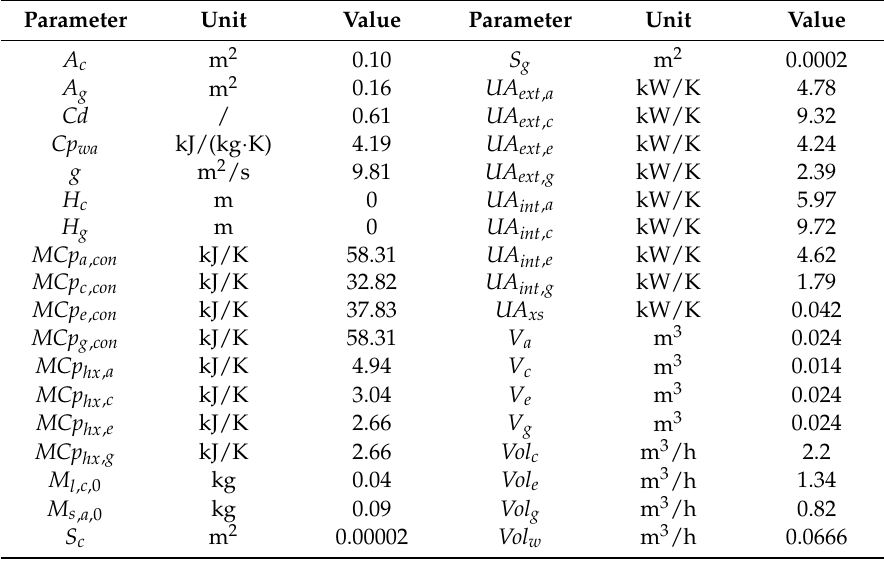
Table 1. Constant parameters for the absorption chiller dynamic